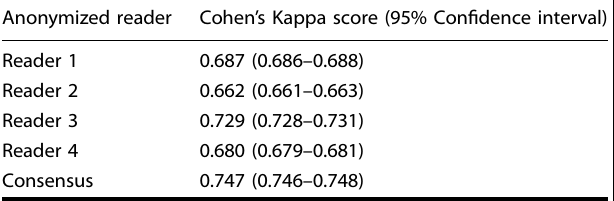
Table 2. Reader study inter-observer agreement: Kappa statistics for agreement in level of TDLU involution between four individual readers, the consensus of their reads, and the CNN.